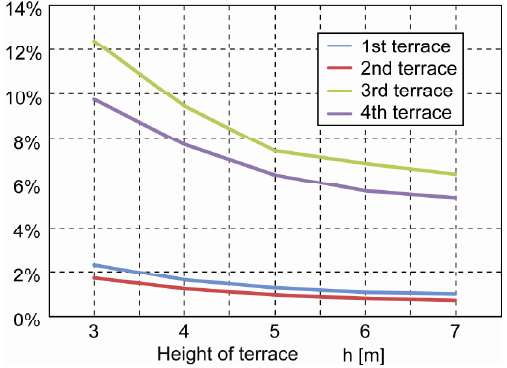
Fig. 21. Trend of change of effect of revolutions of motor n m